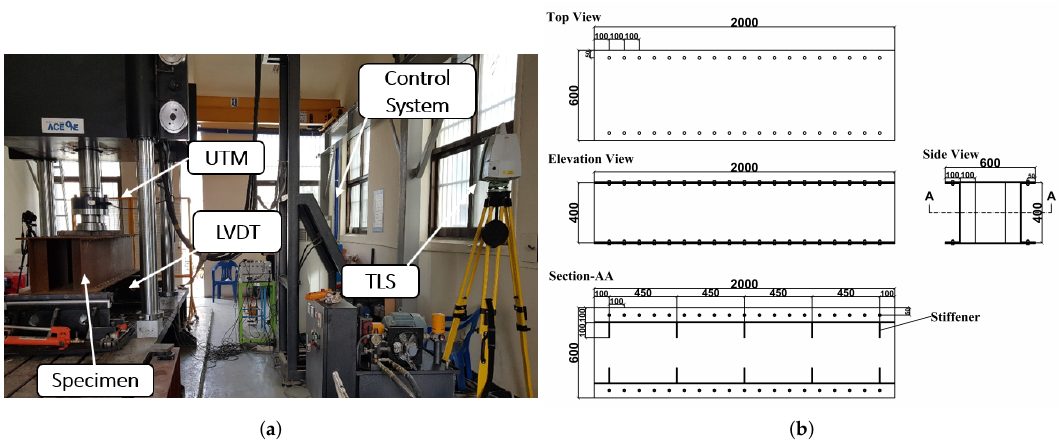
Figure 6. ( a ) Photographic view of the experimental Setup; ( b ) Detailed drawing of the specimen and